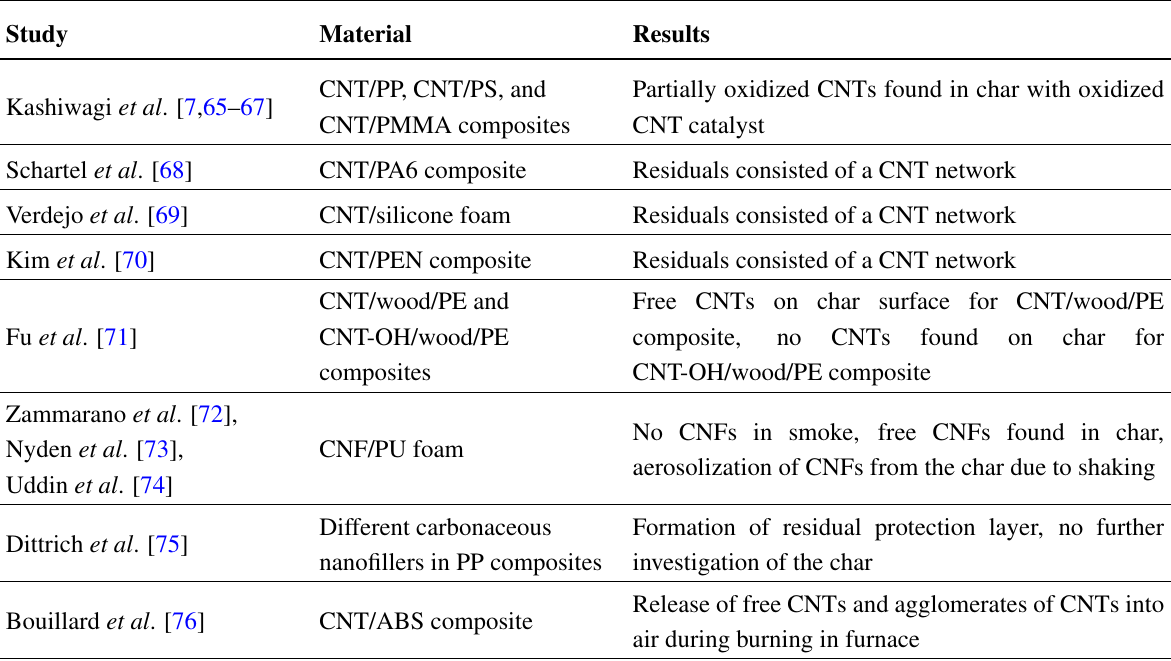
Table 4. CNT release